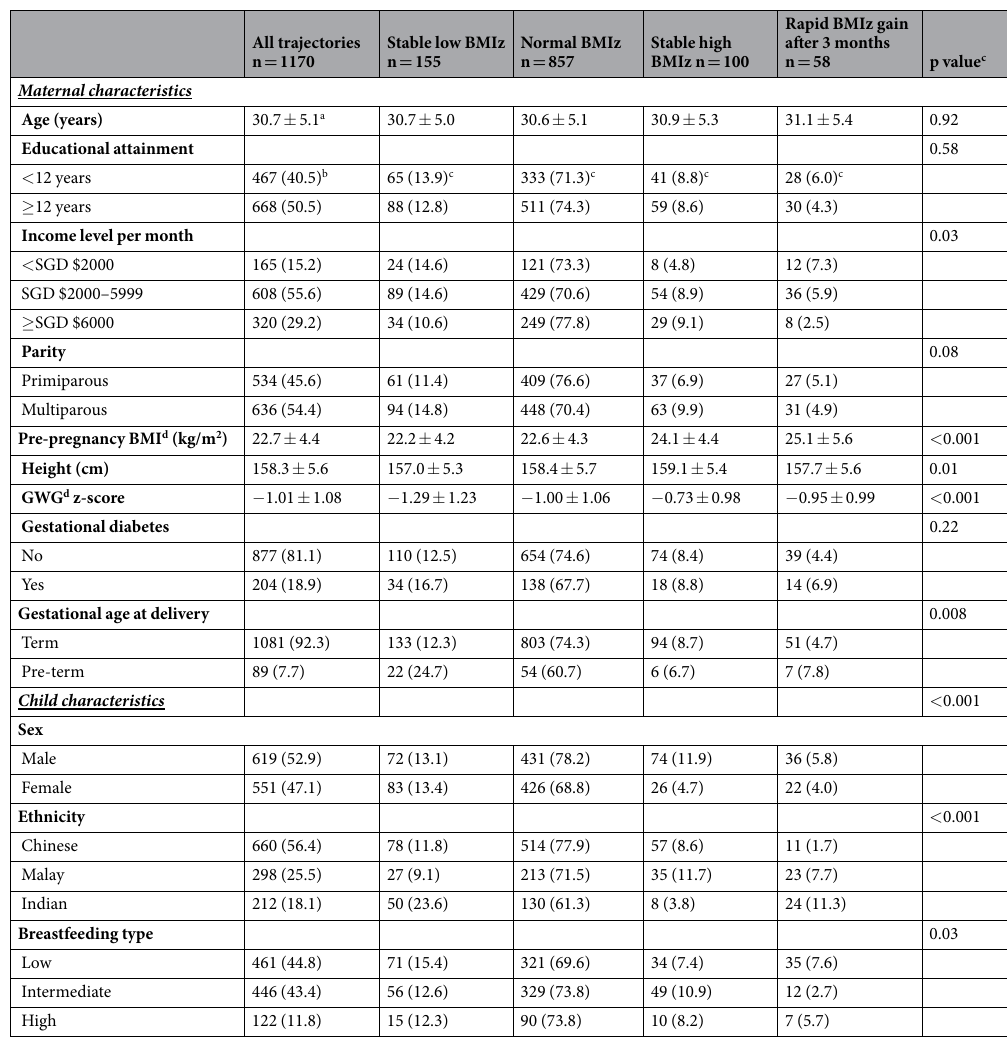
Table 1. Demographic and clinical characteristics according to BMI z-score trajectories. a Mean ± SD. b n (%); indicates column percentages. c n (%); indicates row percentages. c Based on one-way ANOVA (for continuous variables) or chi-square test (for categorical variables). d Abbreviations: BMI = body mass index; GWG = gestational weight